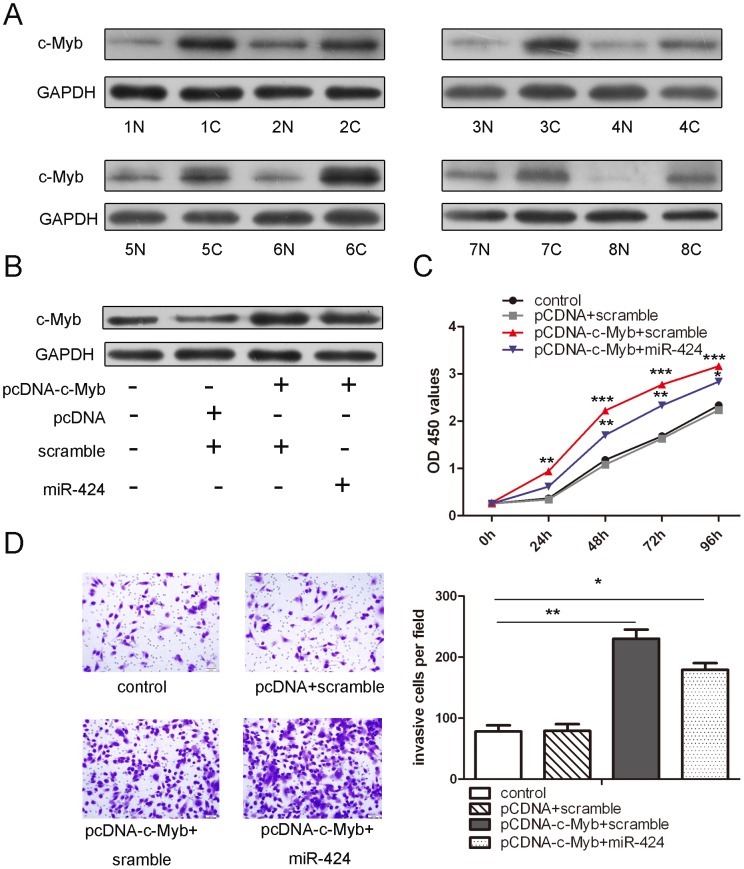
Overexpression of c-Myb impairs miR-424-induced inhibition of proliferation and invasion in HCC cells.(A) Western blot analysis of c-Myb expression in 8 miR-424 down-regulated HCC tissues. GAPDH was also detected as a loading control. (B) Western blot analysis of c-Myb expression in HepG2 cells co-transfected with either miR-424 mimics or scramble and pCDNA-c-Myb or pCDNA empty vector; GAPDH was also detected as a loading control. (C) Cell growth curves in HepG2 cells transfected with different combinations. (D) Transwell analysis of HepG2 cells treated with different combinations. The relative ratio of invasive cells per field is shown right. *p<0.05,** p<0.01, ***p<0.001.